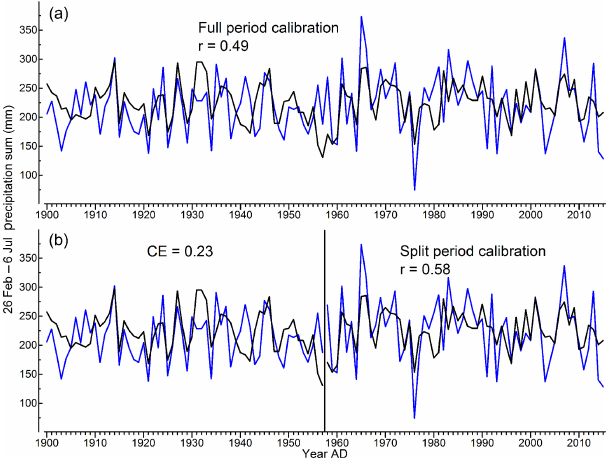
Figure 3. Calibration and verification of the MR oak climate- response analysis. (a) Full (AD1900–2015) and (b) split (AD1958–2015) period calibration. The model was verified dur- ing AD1900–1957. Actual precipitation sums from 26 February to 6 July (blue) and reconstruction (black) are